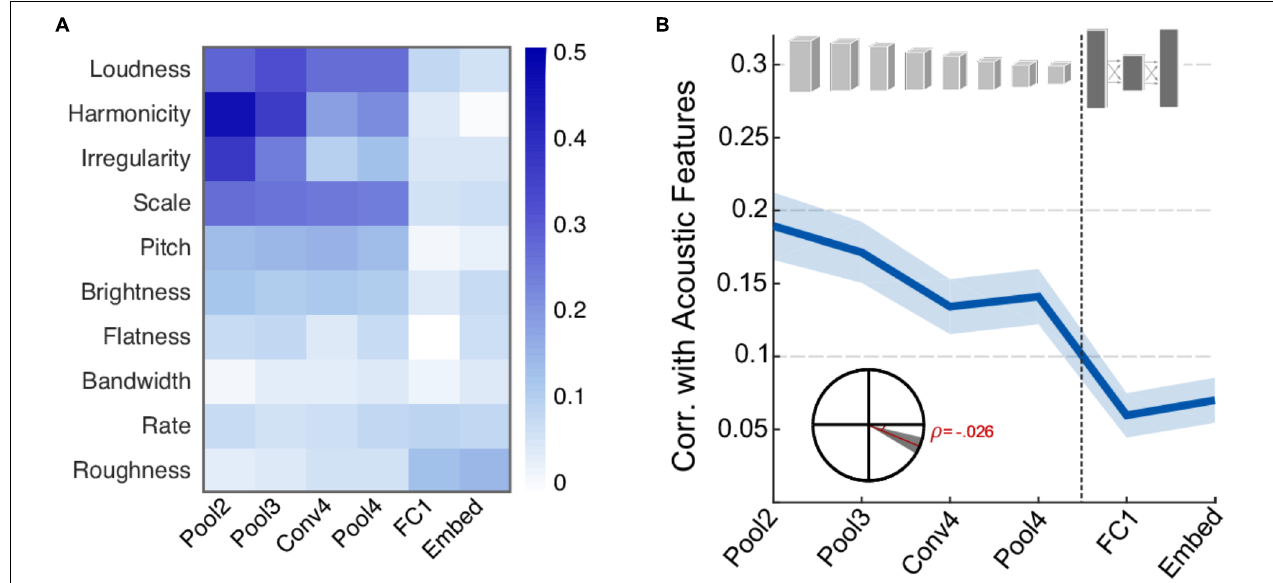
FIGURE 2 | Correlation between neural network activity and acoustic features. (A) Correlation coefficients between individual acoustic features and layers of the neural network. Loudness, harmonicity, irregularity, scale, and pitch are the most strongly correlated features overall. (B) Average correlation across acoustic features and layers of the neural network. Shaded area depicts ± 1 standard error of the mean (SEM). Inset shows the slope of the trend line fitted with a linear regression. The shaded area depicts 99% confidence intervals of the slope.